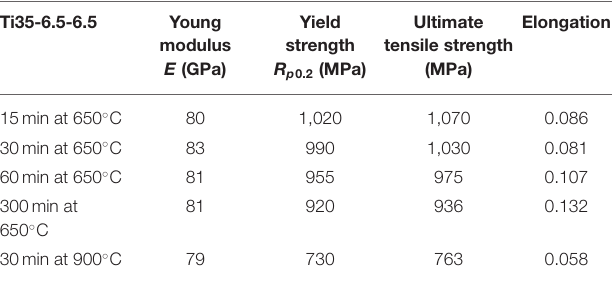
TABLE 2 | Room temperature mechanical properties of Ti35-6.5-6.5 obtained from stress–strain engineering curves performed at a strain rate of 10 − 4 s − 1 for different annealing times at 650 ◦ C and for 30min at 950 ◦